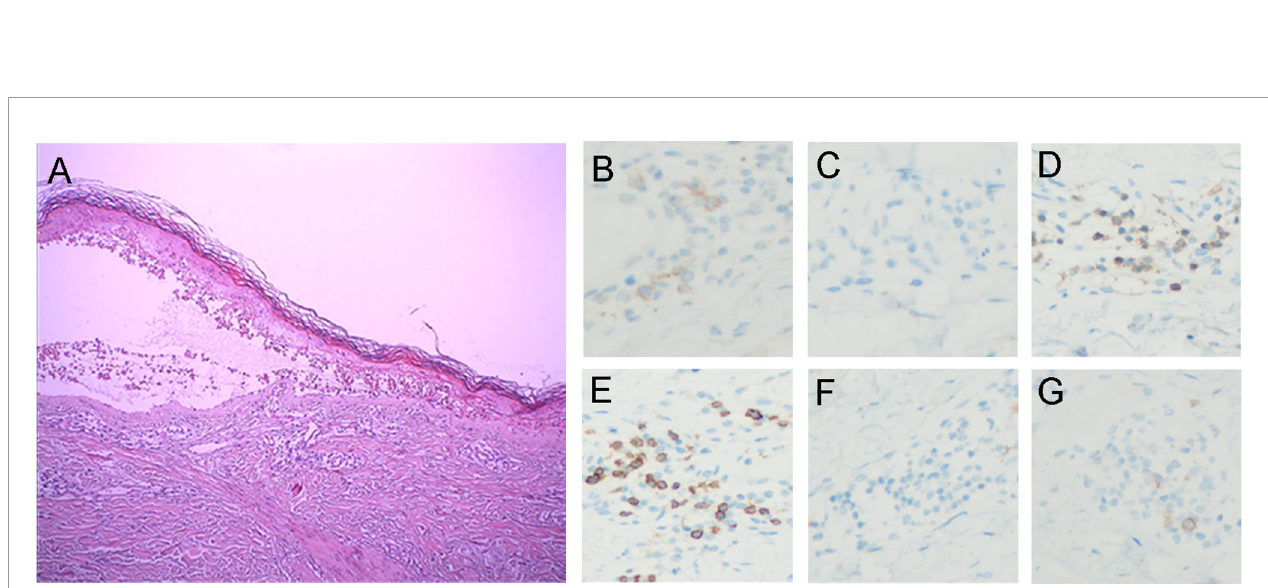
FIGURE 1 | Dermatologic fi ndings. (A – C) Initial inspection revealed generalized rash with blistering which was more severe in load-bearing areas (yellow asterisk), such as the hip, back, and posterior aspect of the arms. (D) Peripheral examination showed severe rash in the hands and feet with associated swelling. (E) Treatment with intravenous immunoglobulin gradually improved his